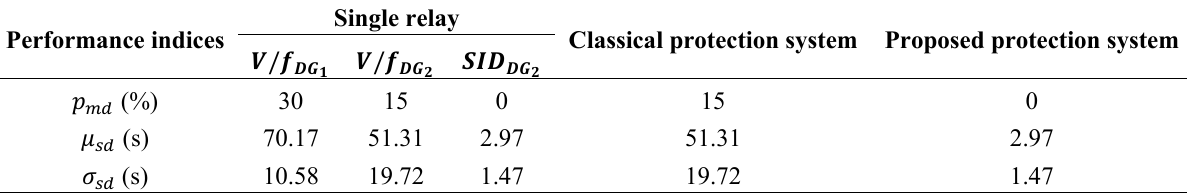
Table 8. Comparison between the classical and the proposed protection systems in the Case B. Performance indices